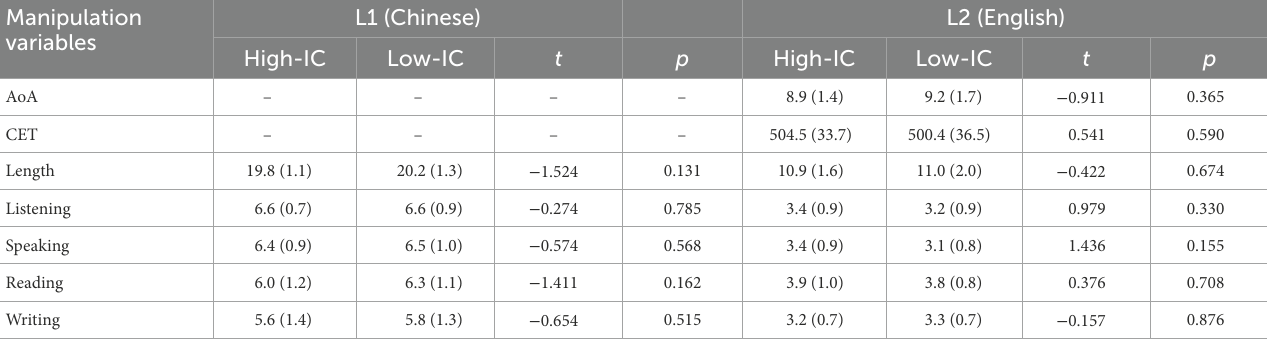
TABLE 2 Means and SDs of the AoA, CET scores, learning time and proficiency ratings of four language skills for high- and low-IC ability groups’ Chinese and English. Manipulation